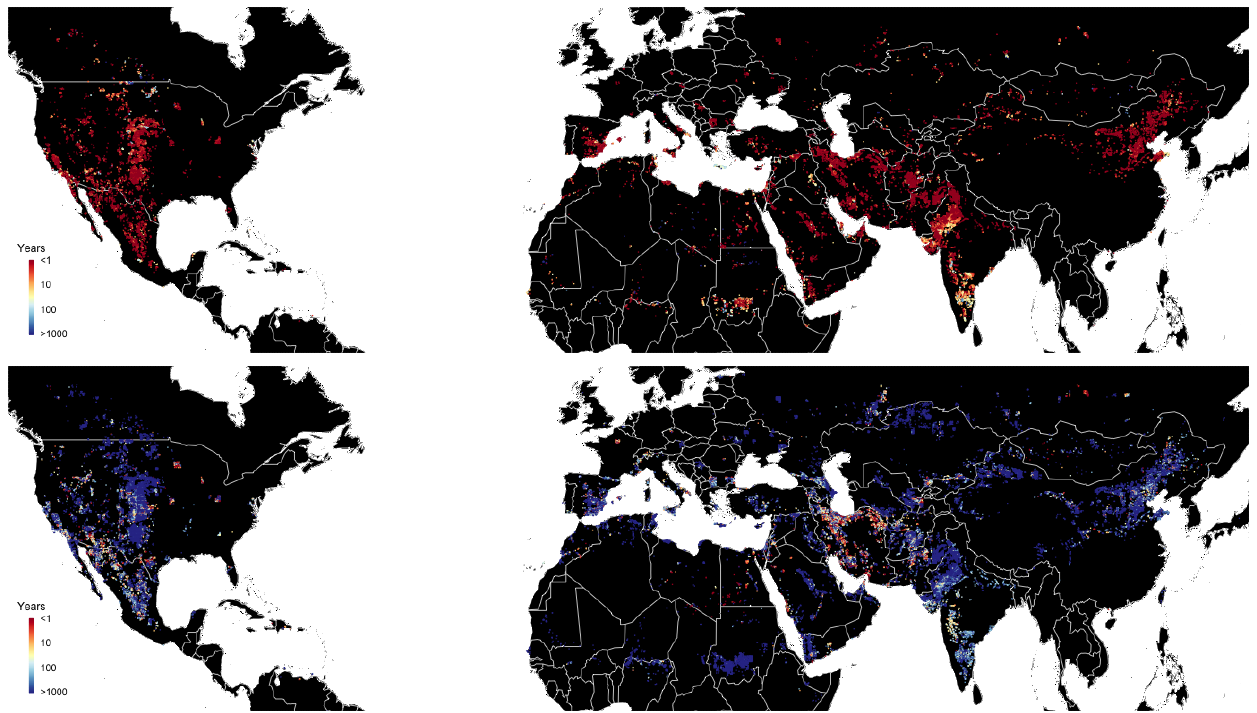
Figure 5. Critical transition times (critical time at which the groundwater level becomes disconnected from the stream after start of pumping, i.e. h < h s in case q > q crit ) calculated with the data from Table 1. The top figure uses C values from Sutanudjaja et al. (2018) and the lower figure from Cuthbert et al.